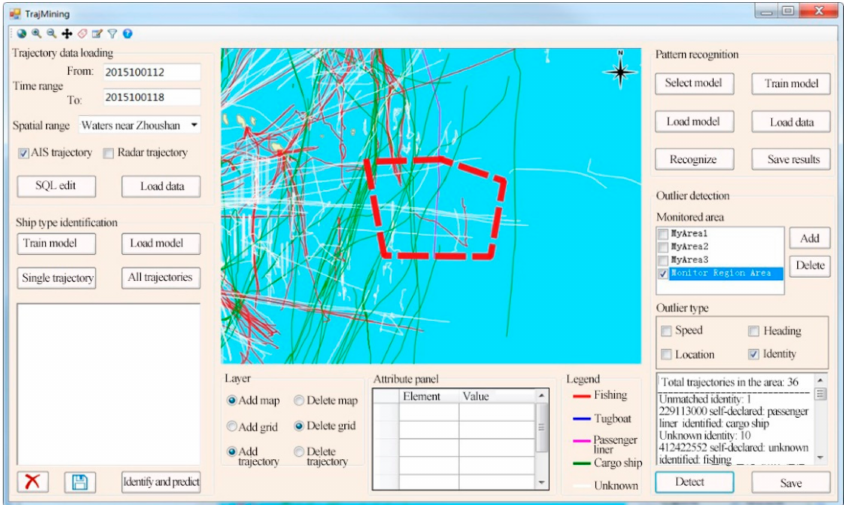
Figure 18. STDMAS ship identity outlier detection